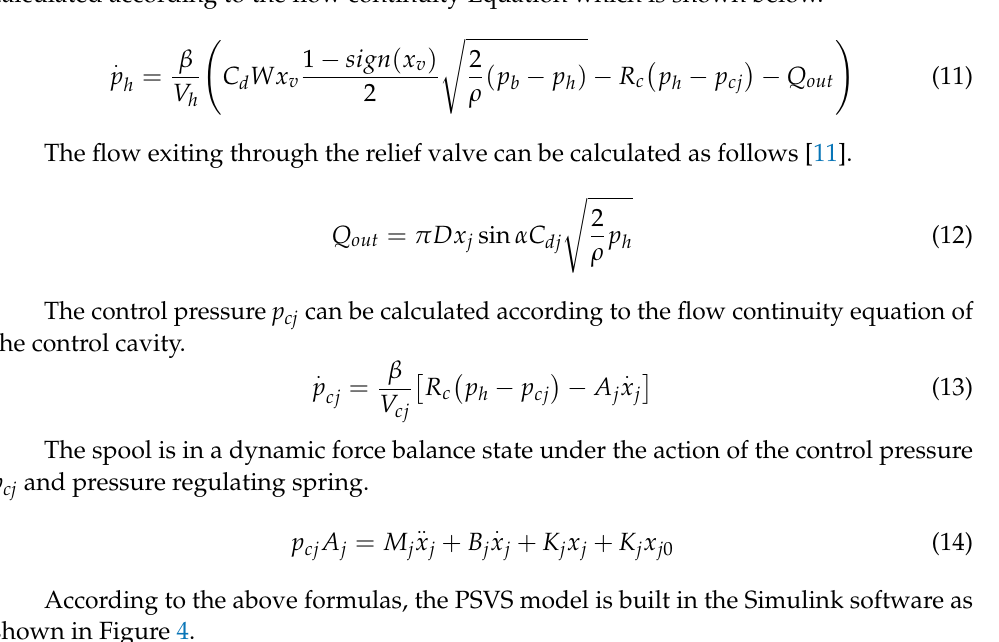
Figure 3. The relief valve: ( a ) The structure of relief valve, ( b ) The simplified principle of relief valve. The channel P of the relief valve is connected to the port H of the pressure servo valve through the pipeline, and the backpressure acts on the control cavity through the internal orifice, forming a control pressure p cj opposite to the pressure regulating spring. If the control pressure p cj exceeds the setting value of the pressure regulating spring, the spool will move along the positive direction ( x j > 0). At this time, the part of the load flow enters the oil return channel through the relief valve, and the change of backpressure can be calculated according to the flow continuity Equation which is shown below.